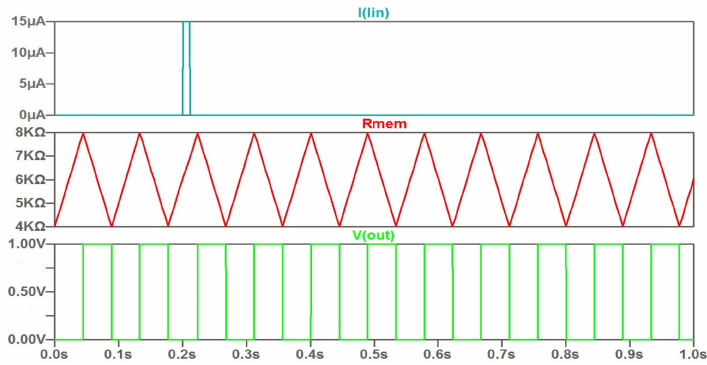
Figure 3. The waveforms under control by narrow current pulse of positive